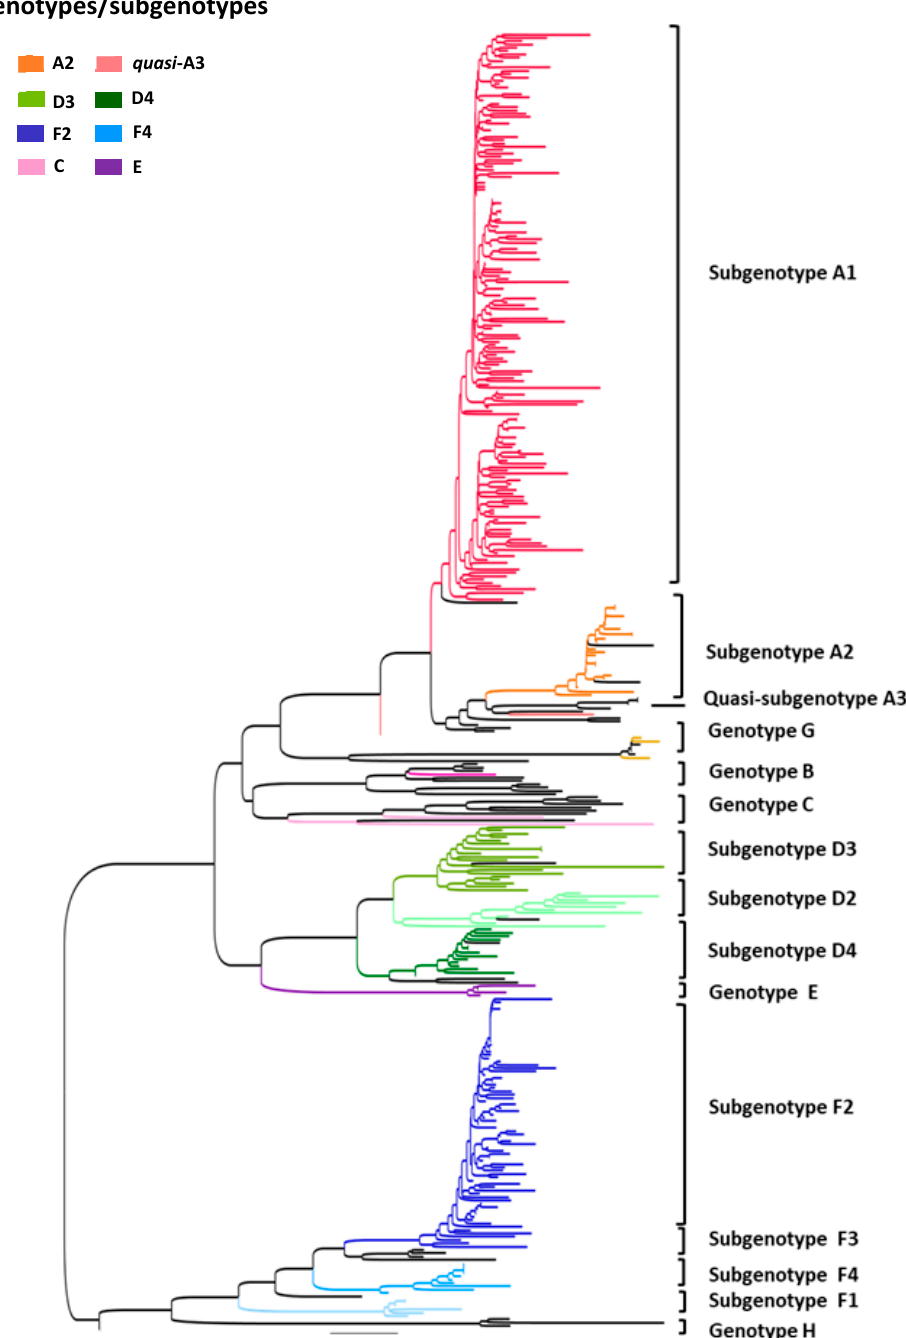
Figure 2. Maximum likelihood phylogenetic tree of all samples enrolled in this study ( n = 321). Each genotype / subgenotype clade is represented by colours discriminated in the legend and taxa used as reference sequences are displayed in black.